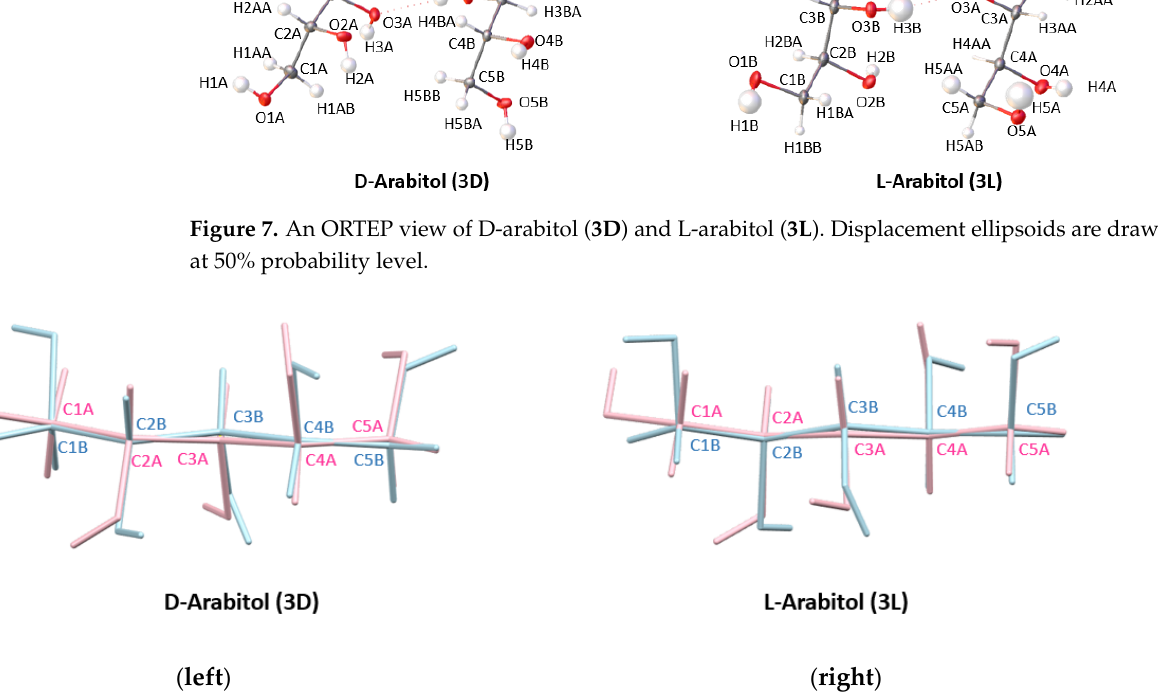
Figure 8. Overlay of molecules in the asymmetric unit cell of 3D ( left ) and 3L ( right ). For both crystal structures, 3L and 3D , the molecules in the asymmetric unit are rotamers.